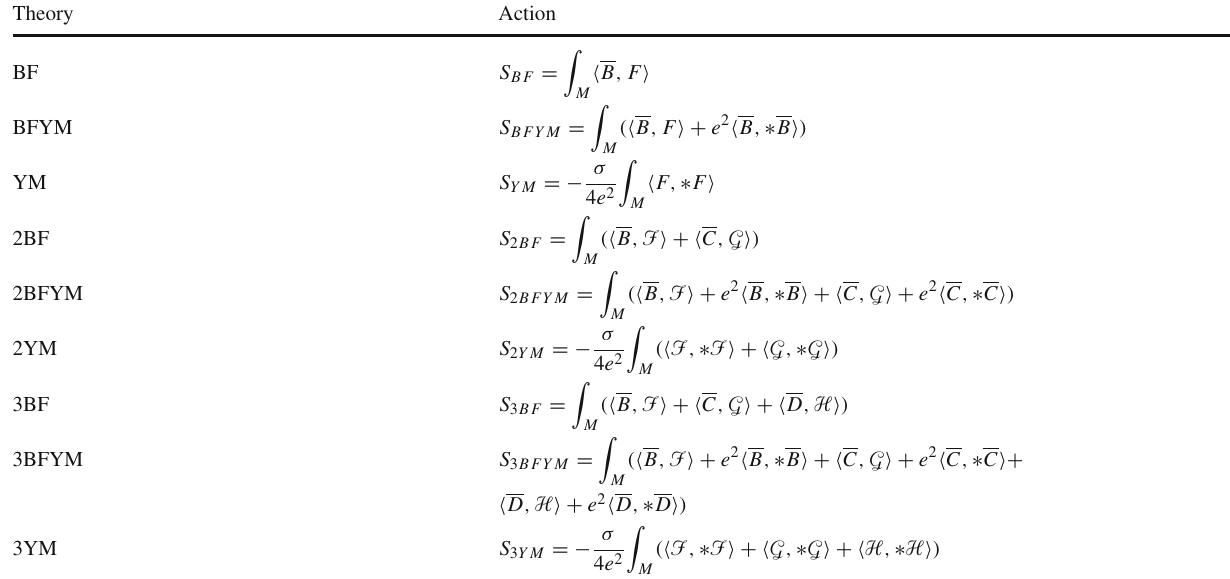
Table 2 The actions of (higher) BF, BFYM and YM theories Theory